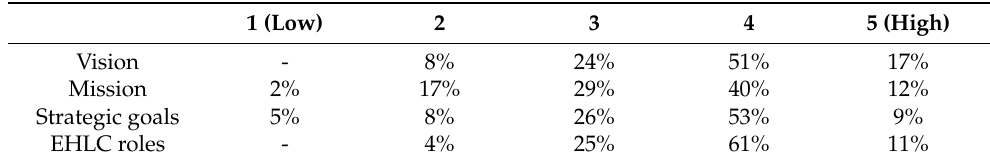
Table 4. Community endorsement of EHLC strategic